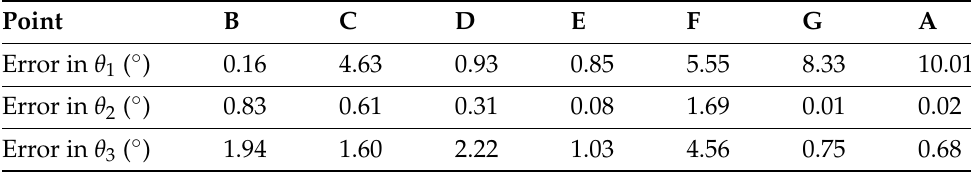
Table 8. Error of the angles of the joints during the accuracy test for the joint